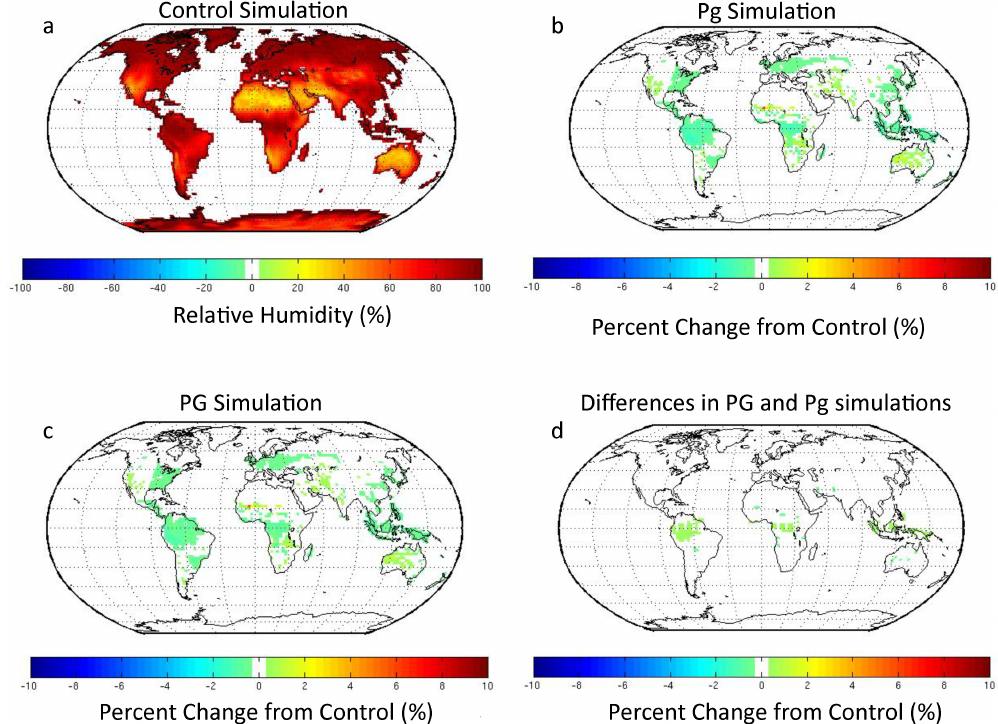
Fig. 7. Mean annual relative humidity (RH) predicted in 20-yr CLM simulations run at 100ppb O 3 . The control simulation (a) shows the average RH annually in the absence of O 3 . The percent changes from control were mapped for the (b) Pg simulation, where a direct change in photosynthesis causes changes in conductance and for the (c) PG simulation, where direct changes to photosynthesis and conductance occur independently. Panel (d) illustrates the differences in RH between the PG compared to the Pg simulation, also mapped as a percent change from control. Note the difference in the scale of panels (b) – (d) compared to previous